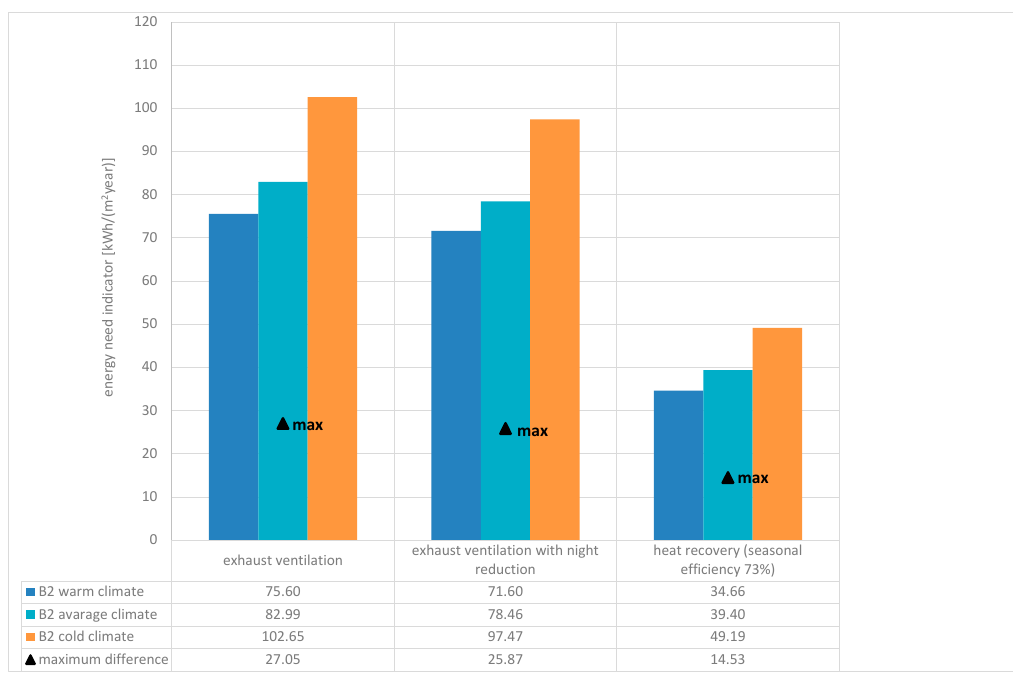
Figure 8. The impact of the type of ventilation system on the energy need indicator.